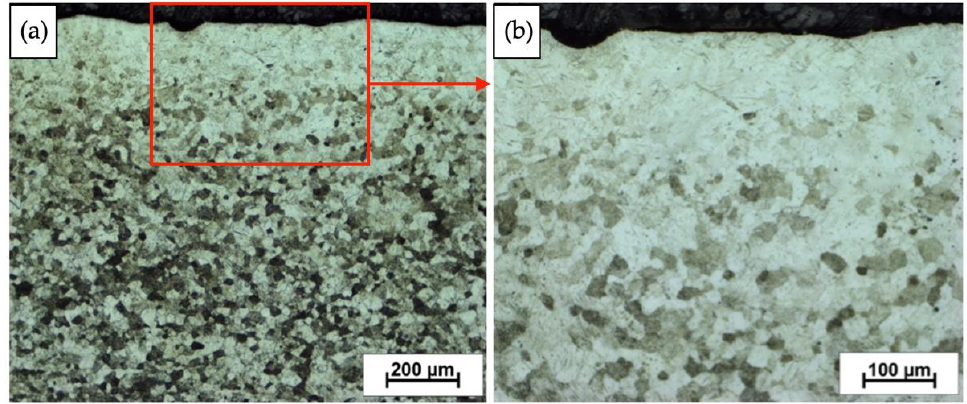
Figure 8. Fragment of a sample deformed with a PBX explosive with the surface area marked. Visible fragments with a coniferous structure. ( a ) Macro image and ( b ) high magnification image (indicated by the red